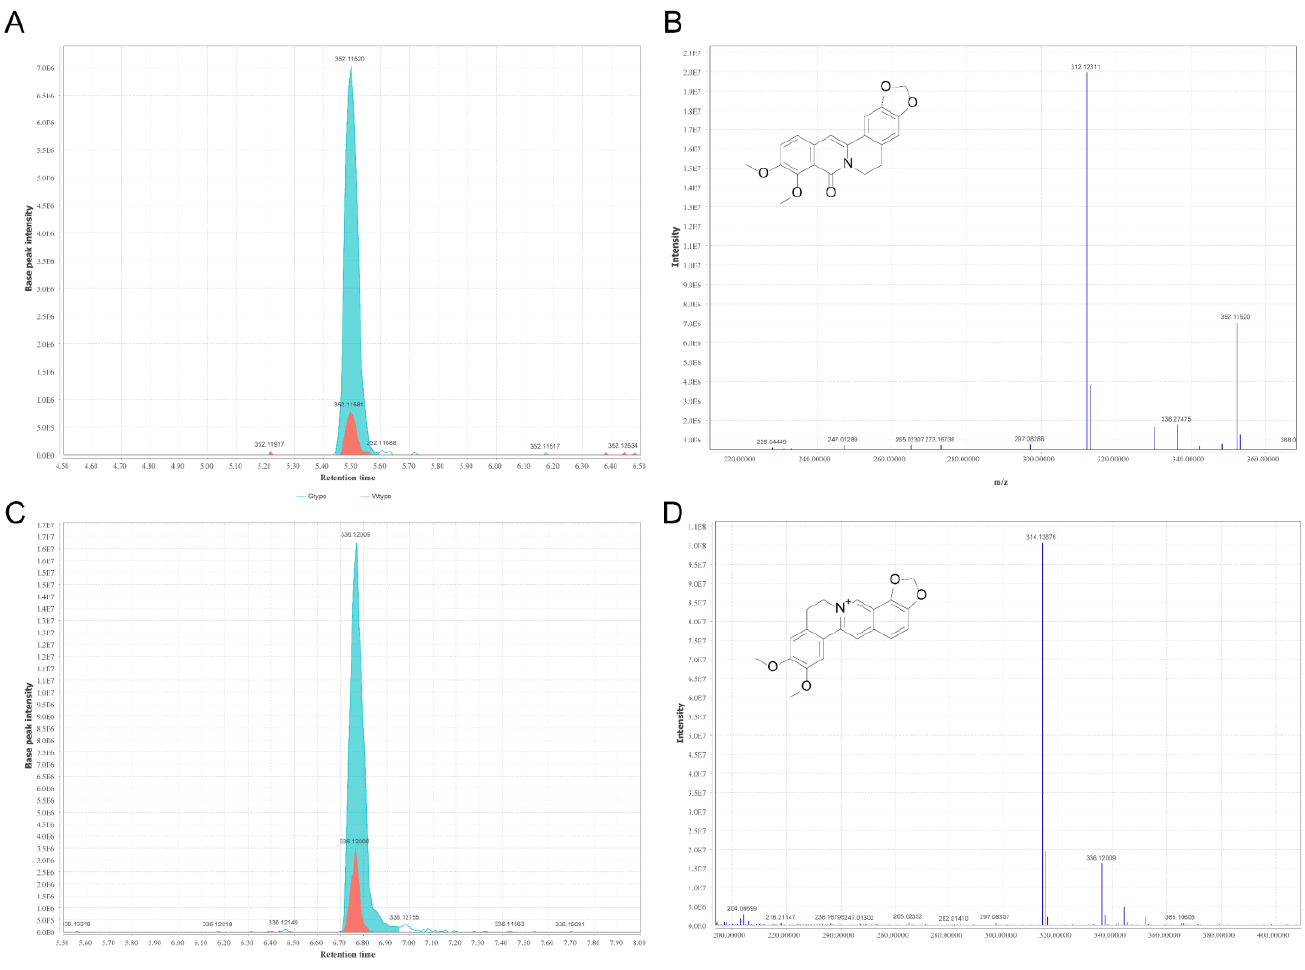
Figure 7. The representative extract ion chromatograms of oxyberberine (m/z 352.11555) of the two types of P. sibiricum acquired in positive ionization mode ( A ) and its MS2 spectra ( B ). The representative extract ion chromatograms of epiberberine (m/z 336.12009) of the two types of P. sibiricum acquired in positive ionization mode ( C ) and its MS2 spectra ( D ).